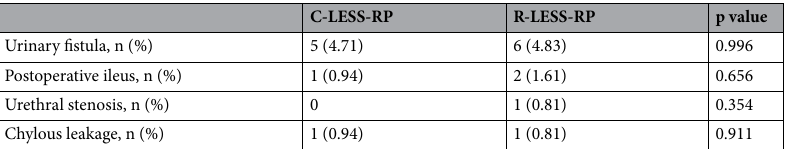
Table 3. Number of patients developed complications after the two surgery approaches ( χ 2 or Fisher’s exact test). C-LESS-RP conventional laparoendoscopic single-site radical prostatectomy, R-LESS-RP Robot-assisted laparoendoscopic single-site radical prostatectomy.